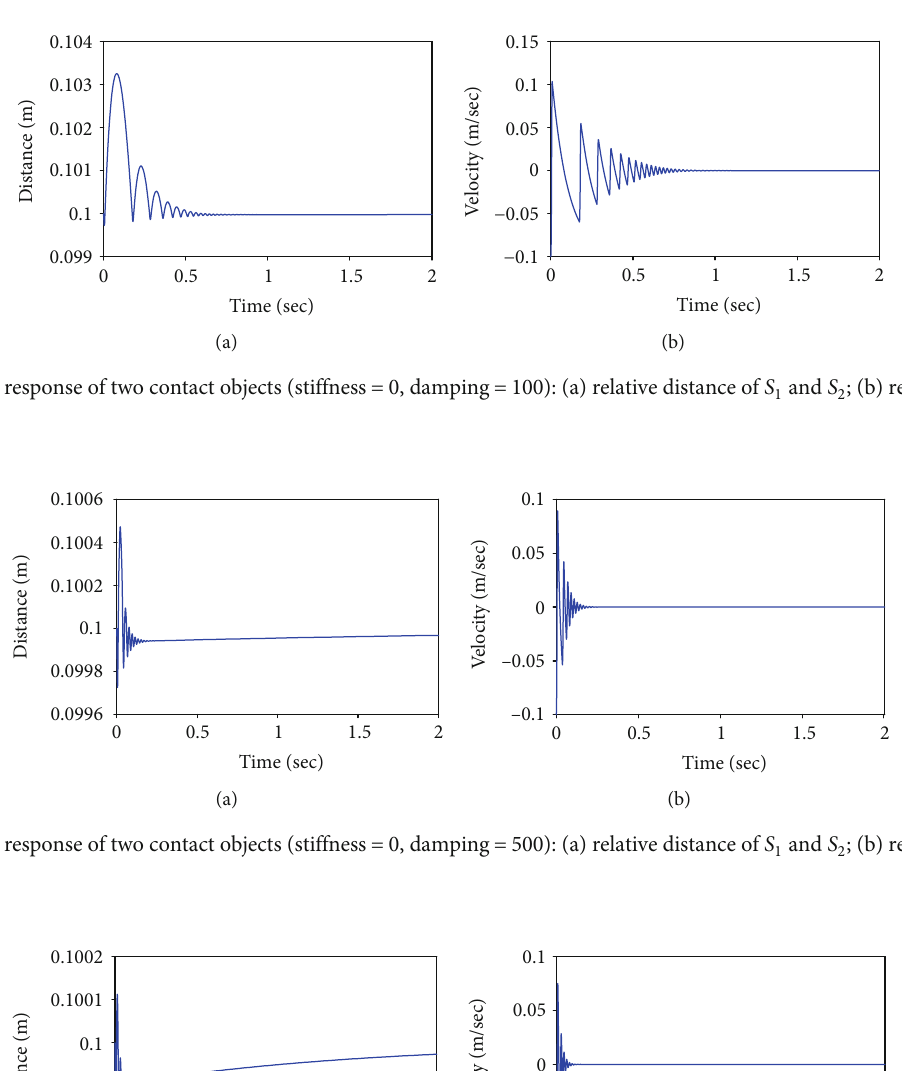
and S ; (b) relative velocity of S 1 2